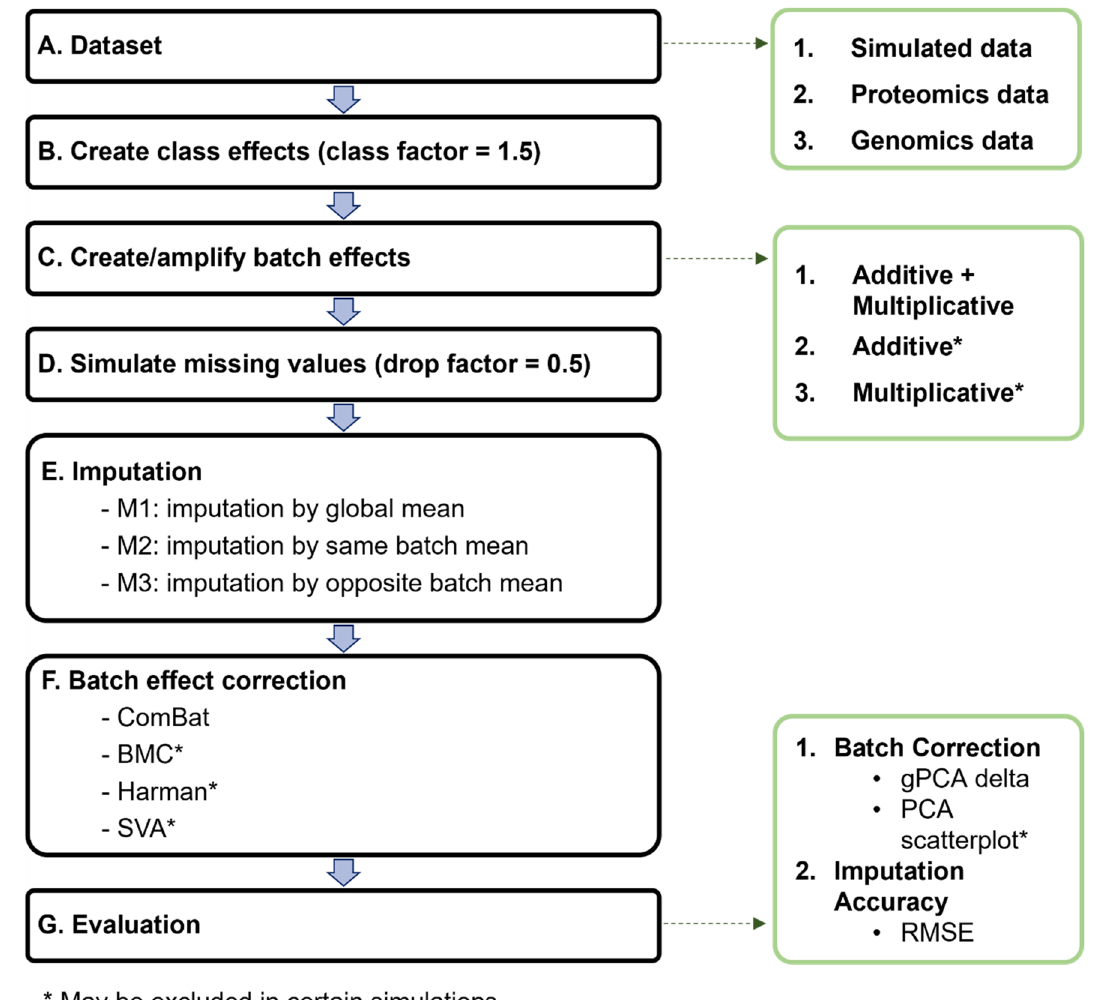
Figure 1. ( A ) 3 types of datasets are used for this analytical pipeline: simulated data for 1. Initial Simulation, Renal Control dataset (RCC) for 2. Proteomics Simulation and lastly, GDS4056/4057 combined dataset for 3. Genomics Simulation. Analytical pipeline consists of ( B ) simulating class and ( C ) batch effects, followed by ( D ) introduction of missing values, ( E ) imputation, ( F ) batch correction and G. evaluation. (see Supplementary Methods for more detailed captions for each